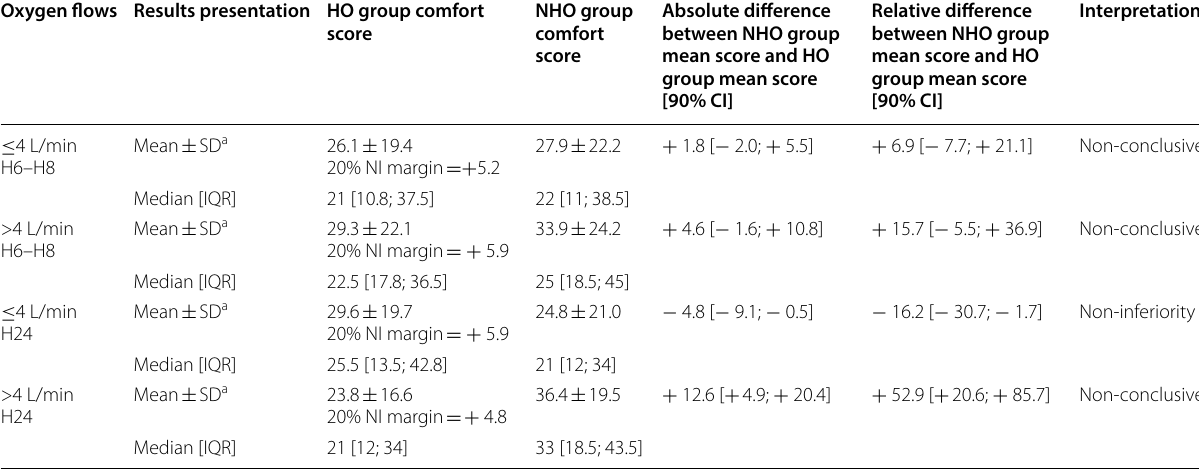
Table 2 Effects of humidification strategy according to oxygen flow rate (non-inferiority analyses) at H6–H8 and H24 (per protocol